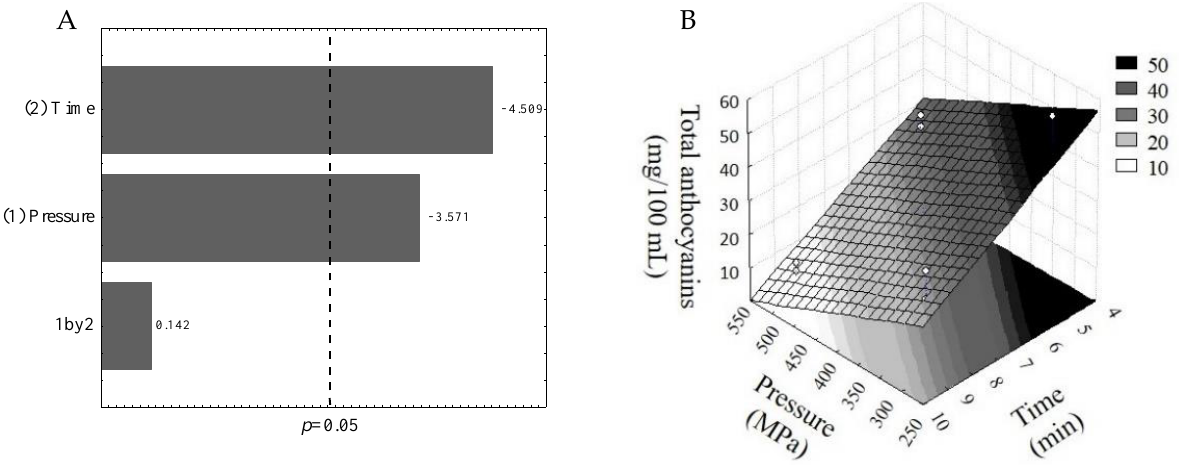
Figure 1. ( A ) Total anthocyanins content in jussara juice was affected by both pressure and time by HPP processing. In this Pareto chart, the standardized effects that reached the dotted line ( p = 0.05) are statistically significant. ( B ) Surface response chart obtained from the experimental design results, showing the total anthocyanins content as a function of HHP processing conditions.